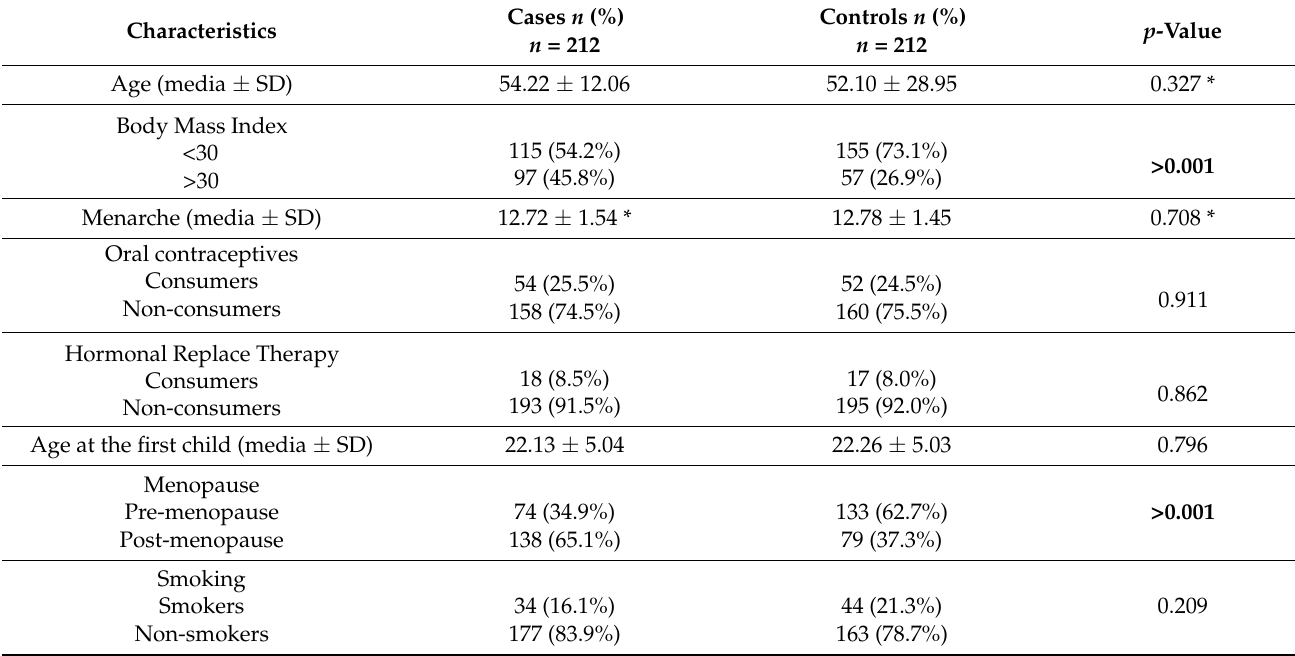
Table 2. Demographic and clinical characteristics of cases and